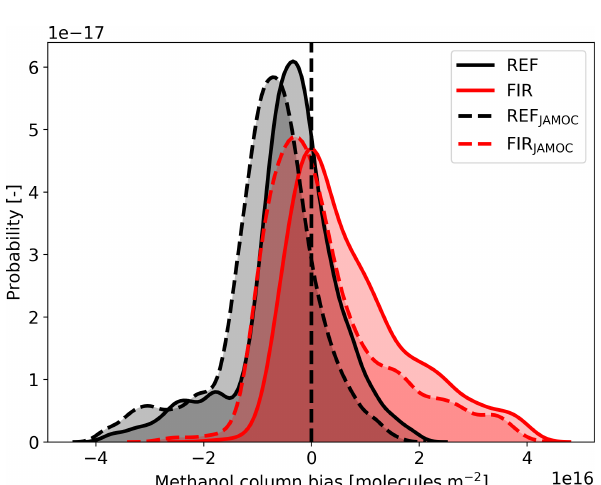
Figure 16. Probability density function of EMAC’s methanol col- umn bias compared to the IASI satellite measurements for simula- tion REF, FIR, REF JAMOC , and FIR JAMOC in SEA during the 2015 Indonesian peatland